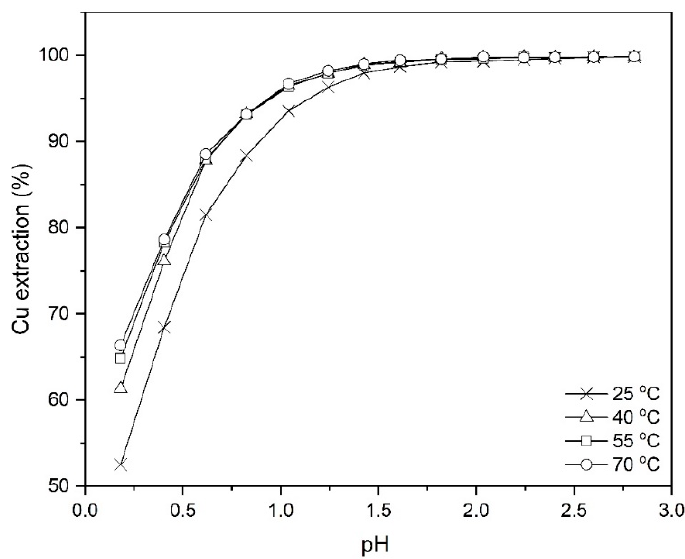
Figure 10. Effect of temperature on Cu extraction at different pH values (Mextral 5640H = 10% ( v / v ), O/A = 1:1, t = 30 min, rpm = 400).